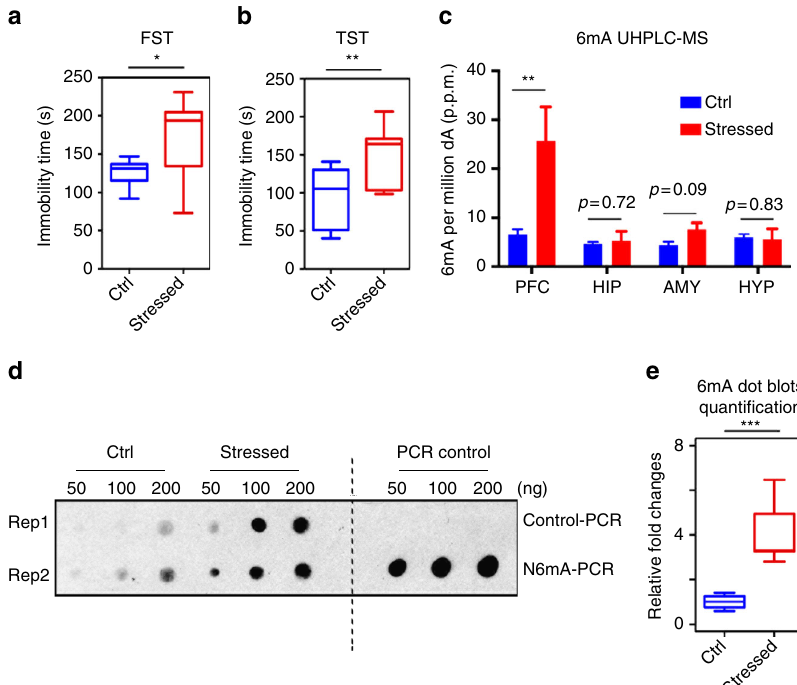
Fig. 1 Chronic stress induces 6mA accumulation in mouse prefrontal cortex (PFC). a , b Chronic stress resulted in increased immobility time in the forced swim test (FST) and tail suspension test (TST). ( n = 9; * p < 0.05; ** p < 0.01; unpaired t -test, error bars = mean ± SEM, unpaired t -test). c Highly sensitive ultra-performance liquid chromatography tandem mass spectrometer (UHPLC-MS/MS) precisely quanti fi ed 6mA in prefrontal cortex (PFC), Hippocampus (HIP), Amygdala (AMY), and Hypothalamus (HYP) upon stress. N (6)-methyladenine/total A was indicated as percentage per million dA (p.p.m.). N (6)- methyladenine levels in PFC drastically increased from 6.6 p.p.m. (6mA per million dA) to 25.5 p.p.m. upon stress (** p < 0.01; unpaired t -test; non- signi fi cant p -values are indicated). d Representative 6mA-speci fi c dot blots revealed accumulation of 6mA in mouse PFC upon stress. Antibody speci fi city has been validated by detecting PCR products using methylated dATP (6mA-PCR) but not unmodi fi ed dATP (control PCR). e Quanti fi cation of dot blots in d by ImageJ software ( n = 4, *** p < 0.001; unpaired t -test, error bars = mean ±